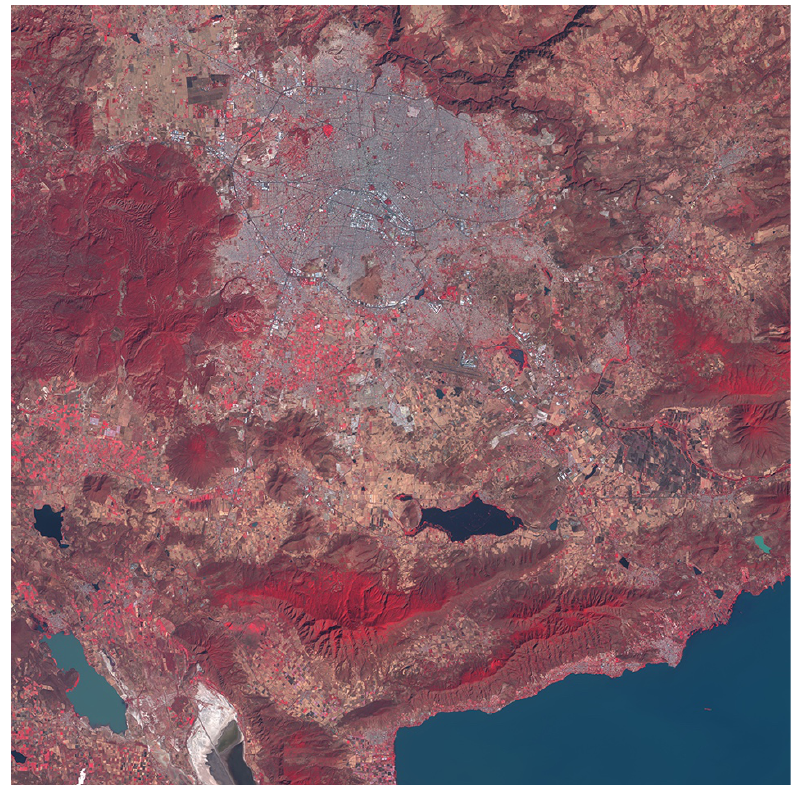
Figure 2. MRS image (presented in false color).